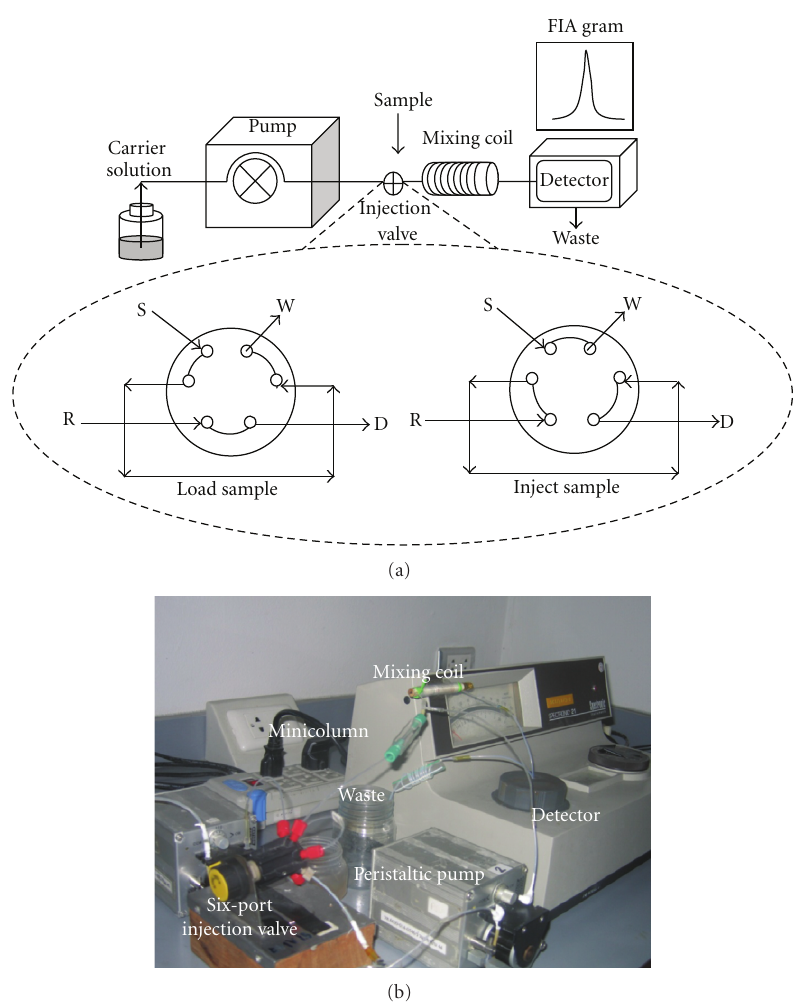
Figure 1: (a) Diagram of a simple flow injection system (S is sample, W is waste, R is reagent, D is detector) and (b) a picture of a simple flow injection system setup showing a peristaltic pump with pump tubing, a six-port injection valve, a minicolumn chemical reactor, a mixing coil, and a detector.